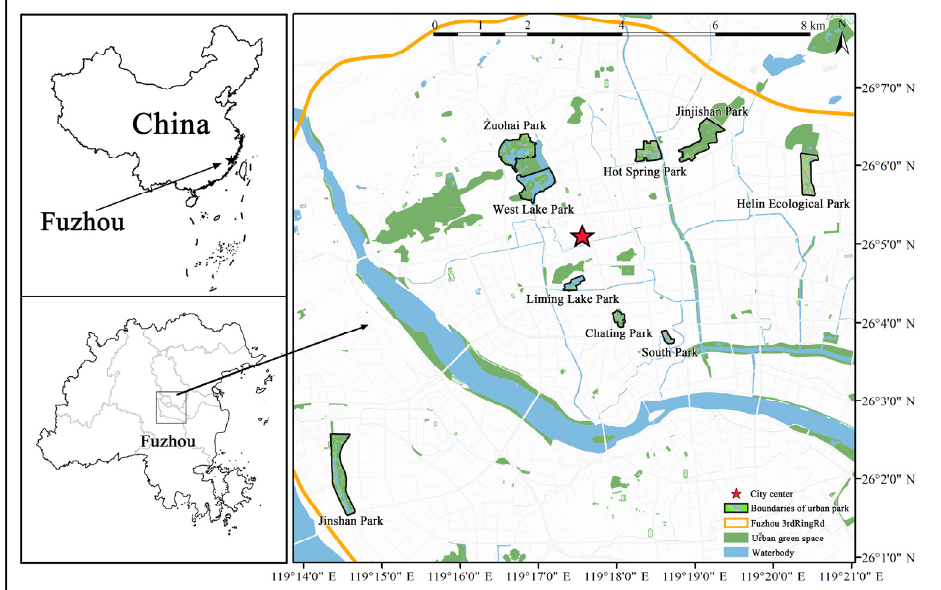
Figure 1. Location of 9 urban parks in Fuzhou. The Orange line represents the Fuzhou third ring road, and the red pentagram represents the location of the city center of Fuzhou (drawn by the author).